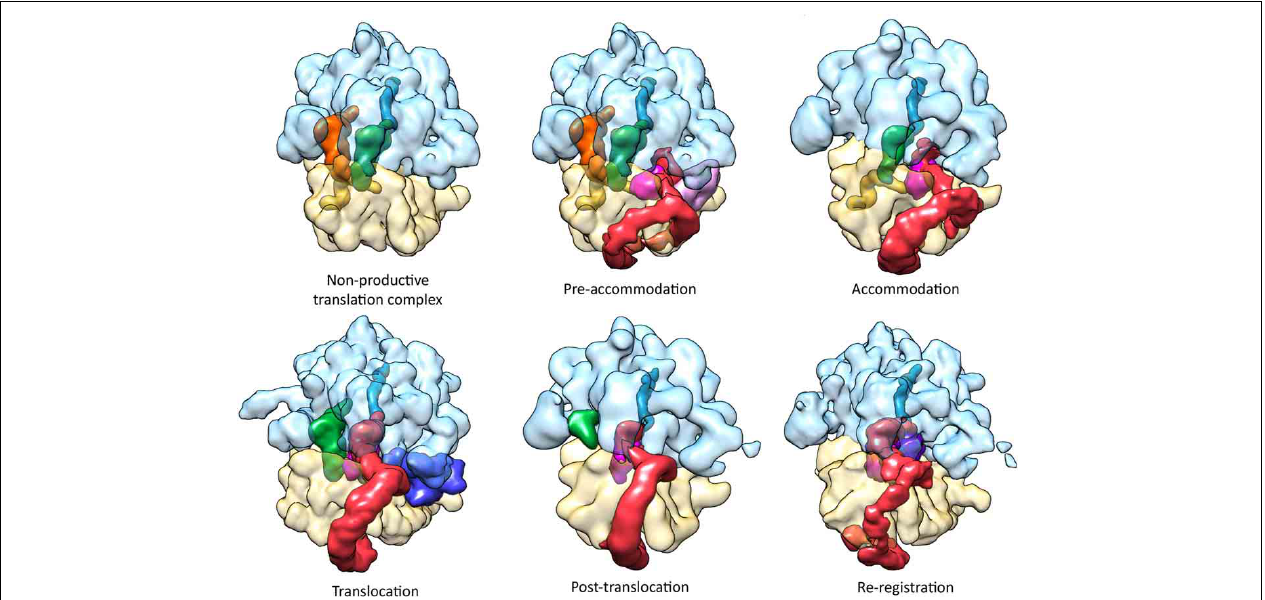
FIGURE 8 | Cryo-EM maps of the currently-solved trans -translation functional complexes. Non-productive translation complex (NTC): the ribosome stalls at the 3 (cid:2) -end of the mRNA, the A-site lacks a complete codon. Pre-accommodation: The alanyl-tmRNA • SmpB • EF-Tu • GTP quaternary complex enters the vacant A-site of a non-stop stalled ribosome (EMDB entry: EMD-1312) (Valle et al., 2003; Kaur et al., 2006). Accommodation: EF-Tu dissociates after GTP hydrolysis, allowing tmRNA-SmpB to occupy the A-site (EMDB entry: EMD-5188) (Weis et al., 2010a). Translocation: EF-G • GTP catalyzes the translocation of tmRNA-SmpB to the P-site. The ribosome is in a ratcheted state and a